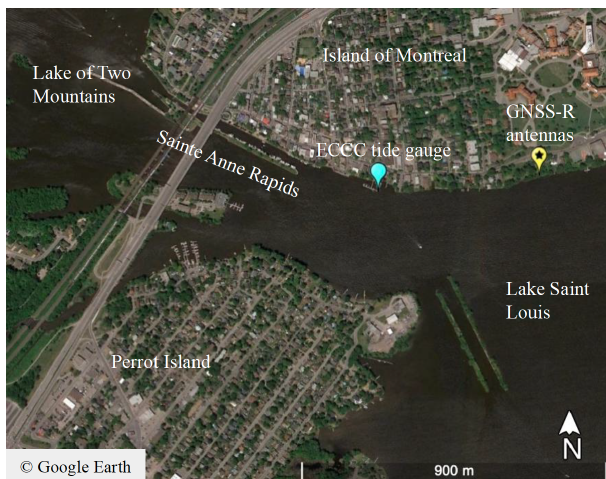
Figure 3. The area surrounding the antenna array and tide gauge at